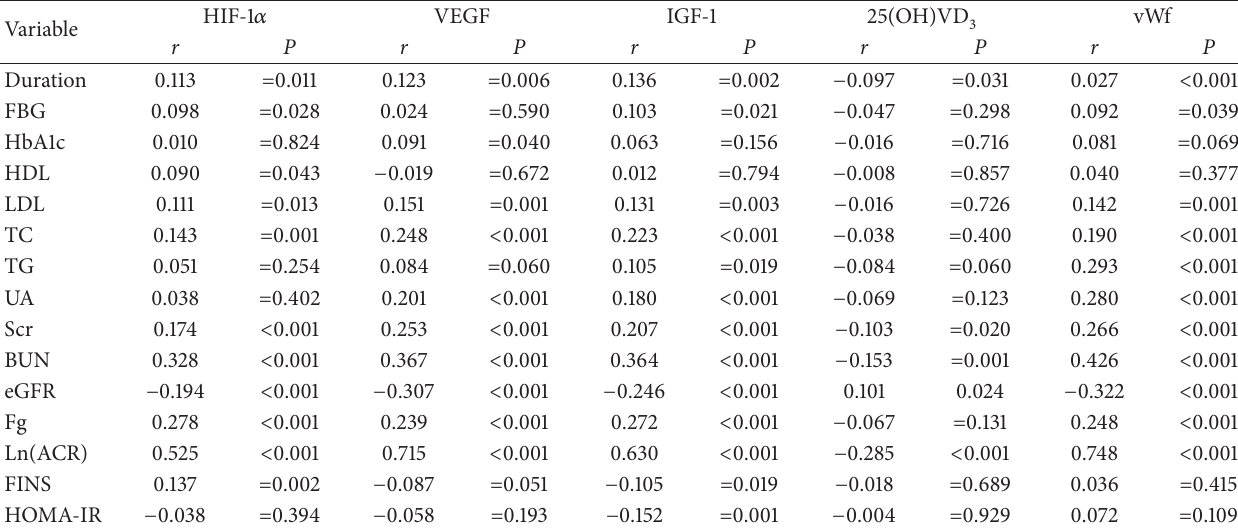
Table 5: Relationship between serum levels of HIF-1 𝛼 , VEGF, vWF, IGF-1, and 25(OH)VD 3 and various